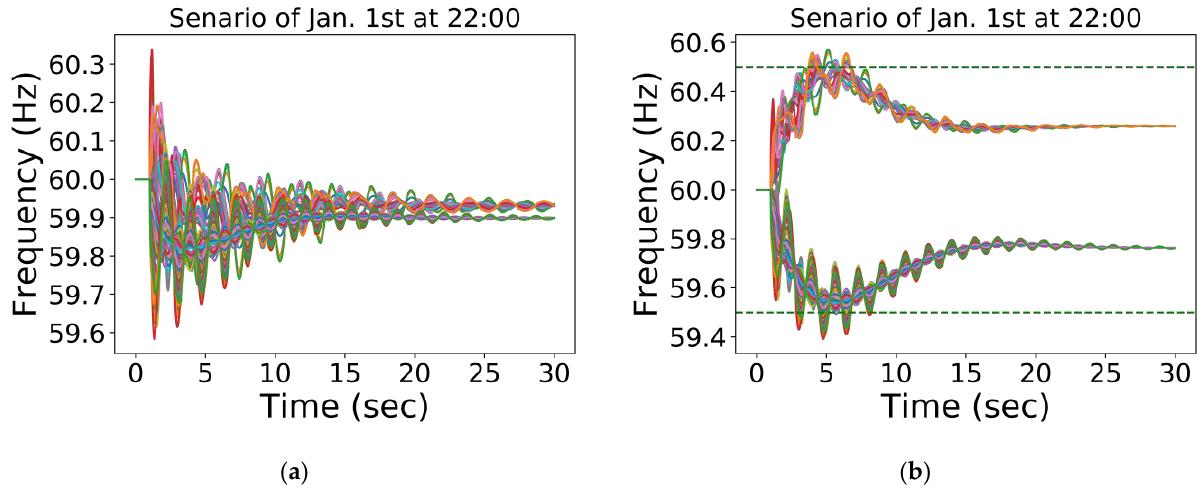
Figure 4. Frequency of two islanded grids. ( a ) Load decrease and load increase according to total tie line flows; ( b ) Optimal load decrease and load increase.